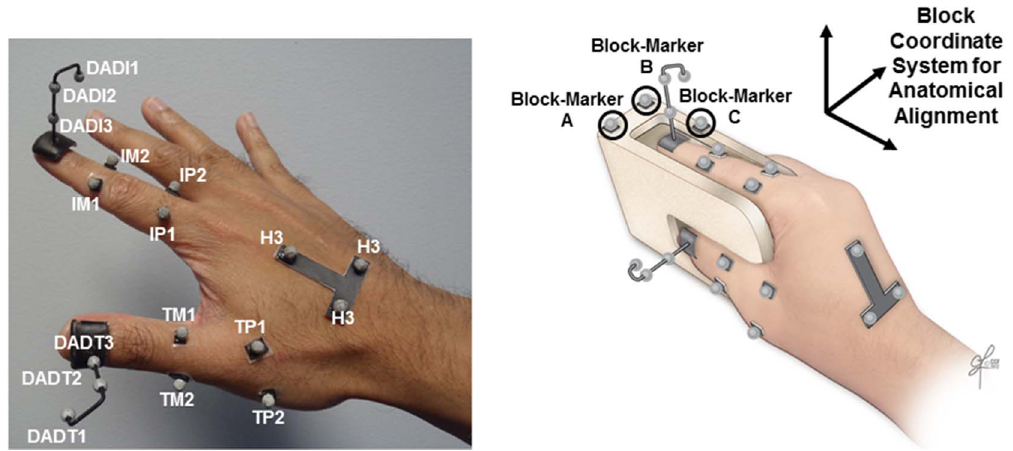
Figure 1. Experimental set-up. LEFT : Markers utilized for motion tracking and computing digit kinematics [13] RIGHT: Calibration using a digit alignment device [14].